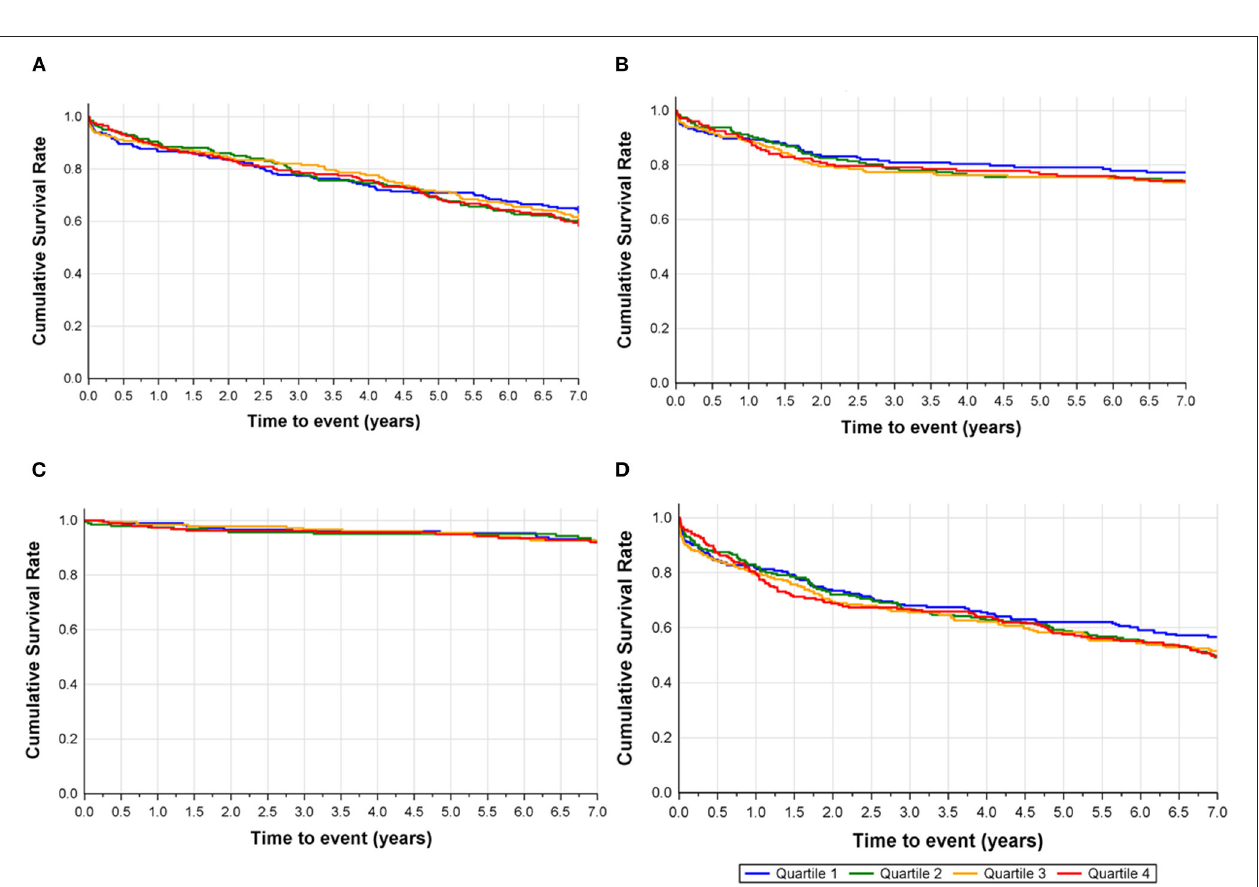
FIGURE 1 | Kaplan-meier plots of endpoints by quartile of podocan, (A) all-cause death, (B) myocardial infarction, (C) stroke and (D) composite of all-cause death, myocardial infarction, or stroke.